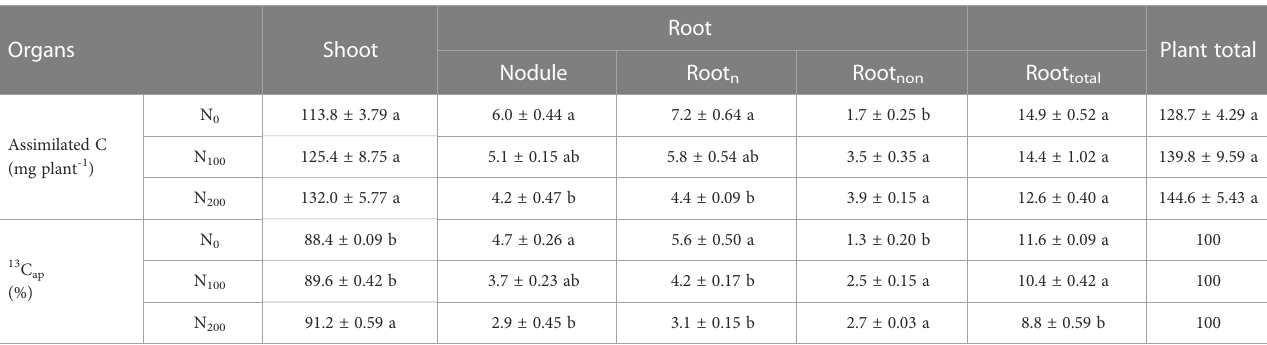
TABLE 3 13 C accumulation and distribution of dual-root soybean plants.